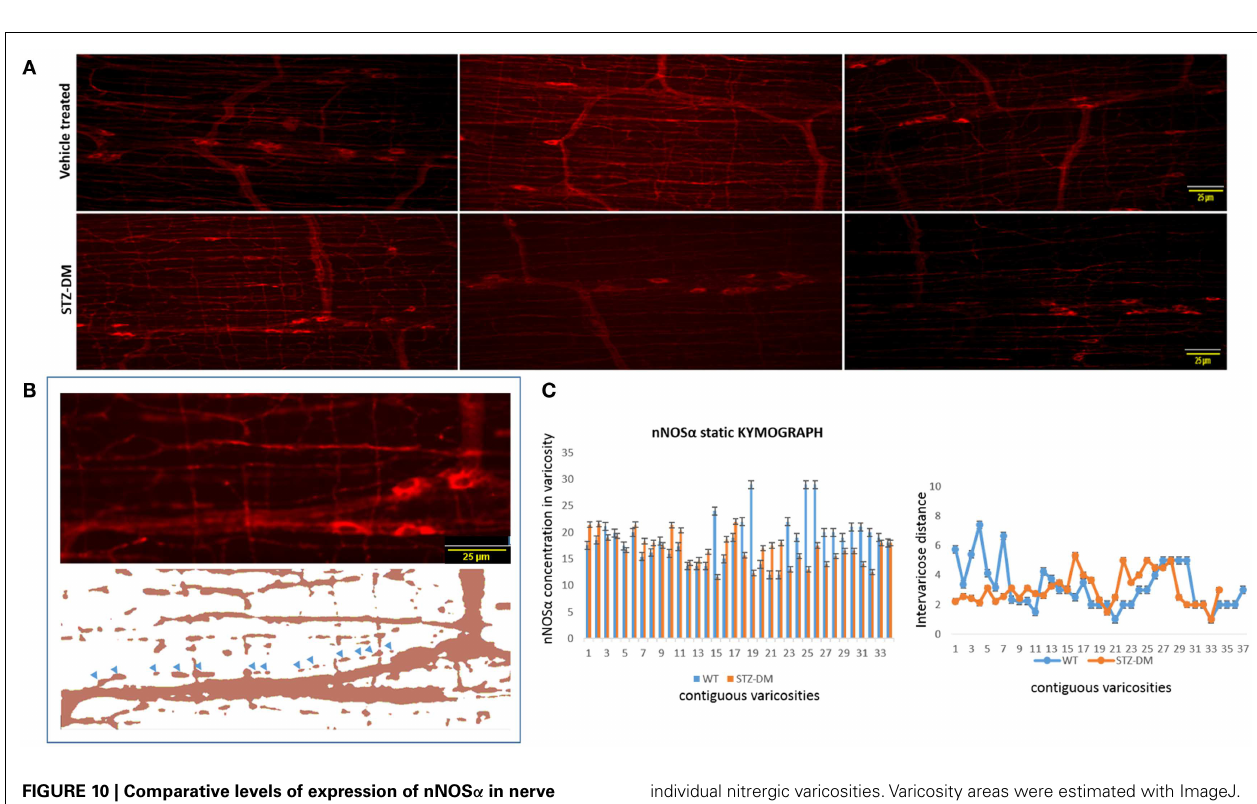
FIGURE 10 | Comparative levels of expression of nNOS α in nerve terminals of both wild type and diabetic tissues (A) . Upper panel shows variance in appearance of nNOS α in vehicle treated and diabetes. Comparative quantitation demonstrated similar nNOS α levels within varicosities. (B) Fluorescent images were thresholded to digitally isolate